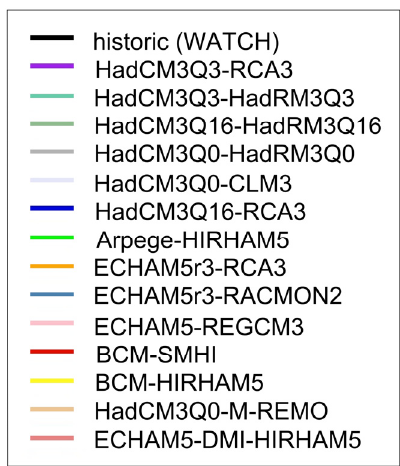
Figure B1. Legend for Figure 4. Historic observations (WATCH data [24]) and fourteen GCM/RCM combinations [21] from the EU-FP6 ENSEMBLES project